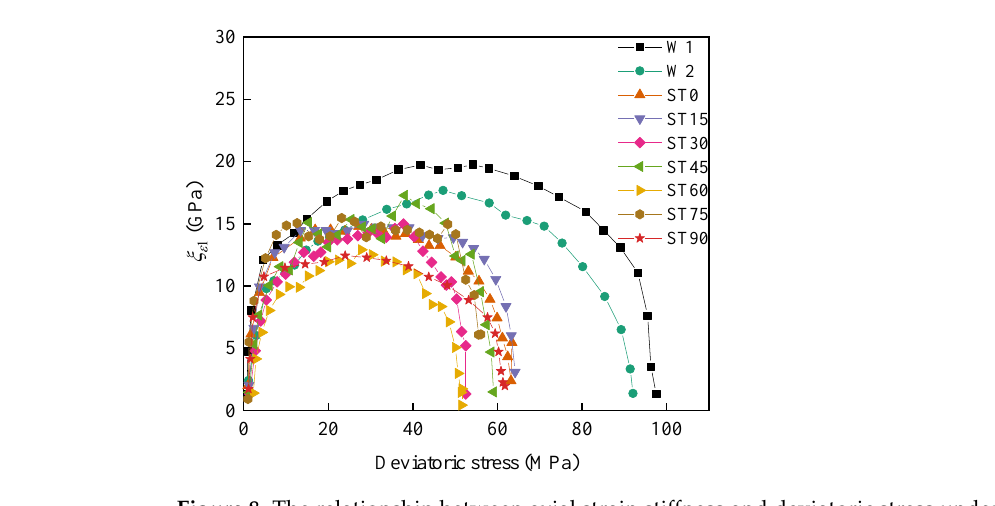
Figure 8. The relationship between axial strain stiffness and deviatoric stress under different angles T-shaped fracture sandstone.